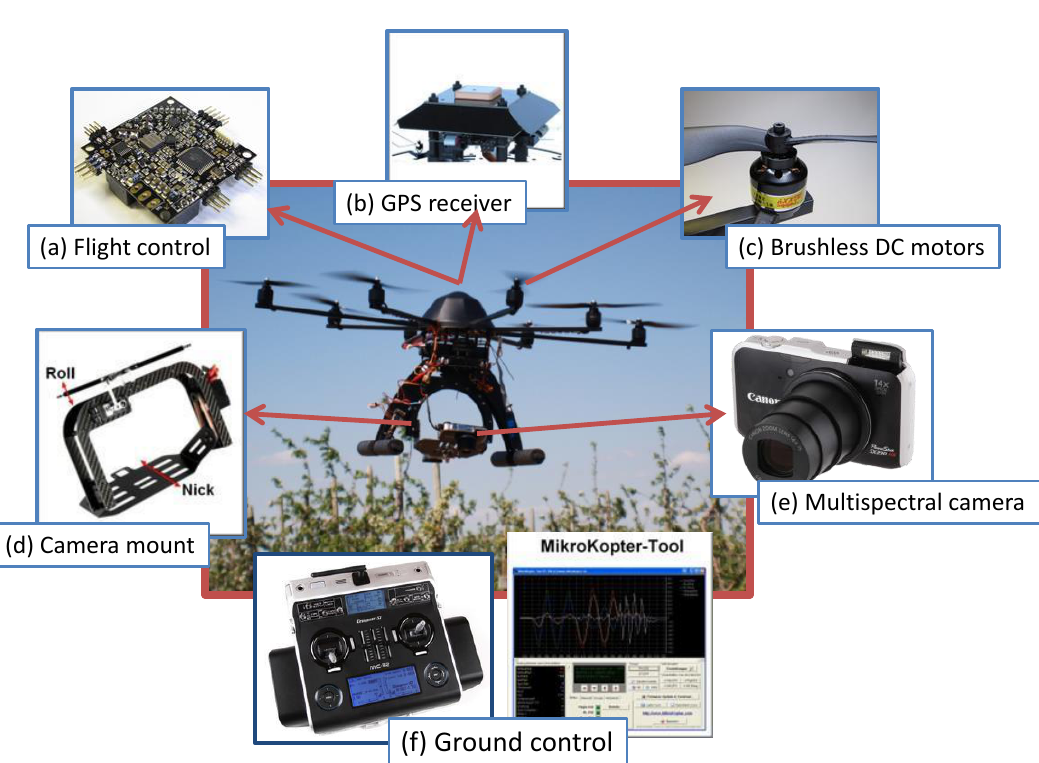
Figure 3. Unmanned aerial vehicle with multispectral camera (vegetation stress camera).